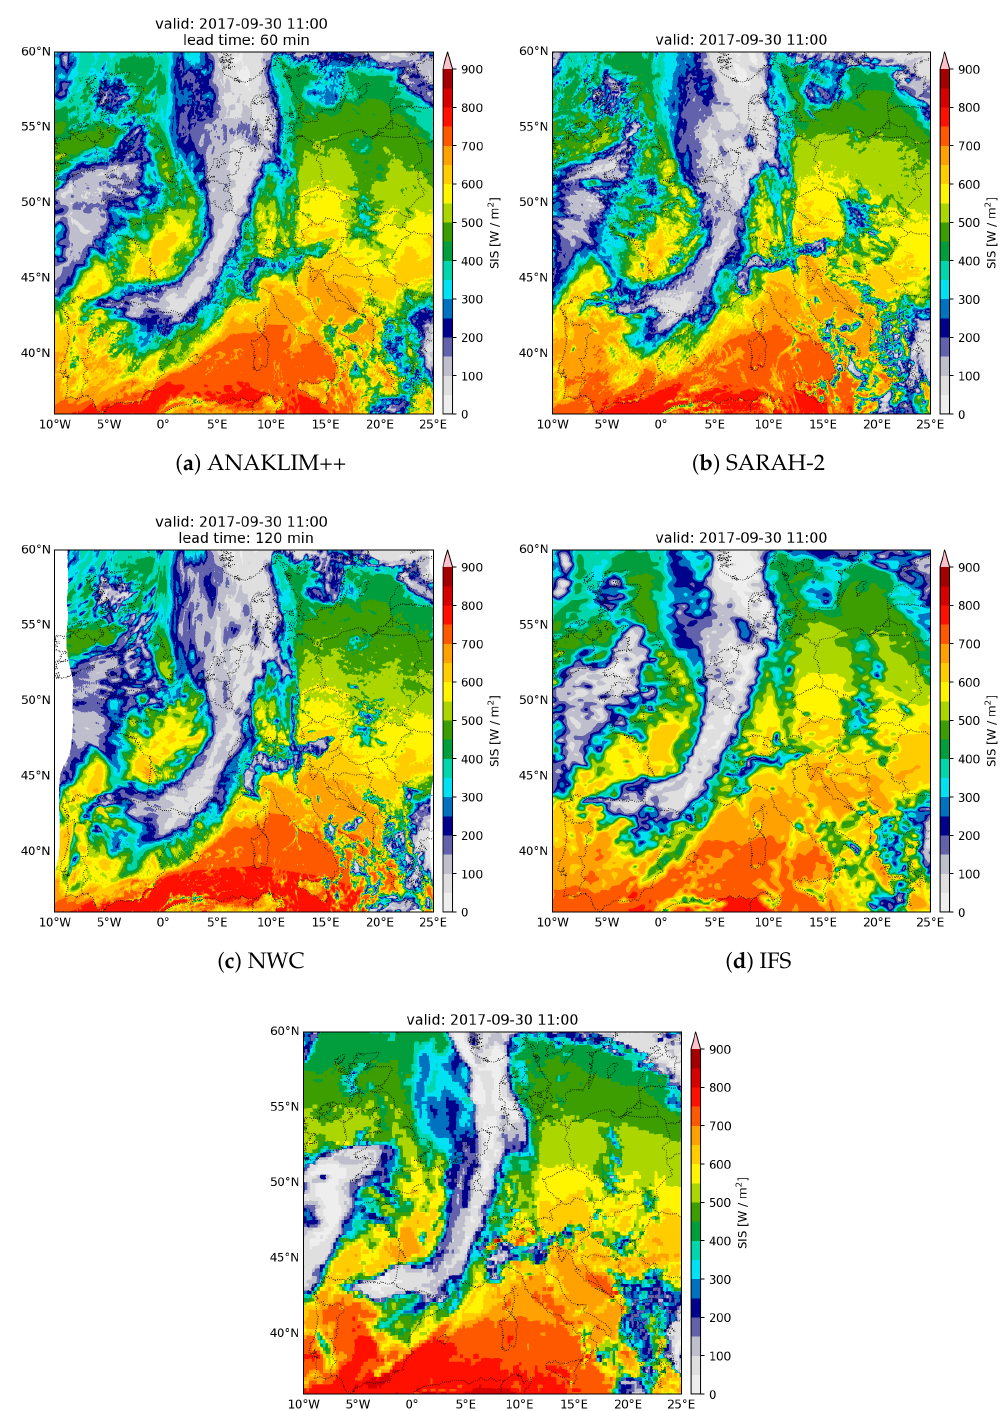
Figure 3. Hourly averaged SIS of ( a ) the blending with ANAKLIM++, ( b ) SARAH-2, ( c ) NWC, ( d ) IFS and ( e ) ICON for 2017-09-30 11 UTC,